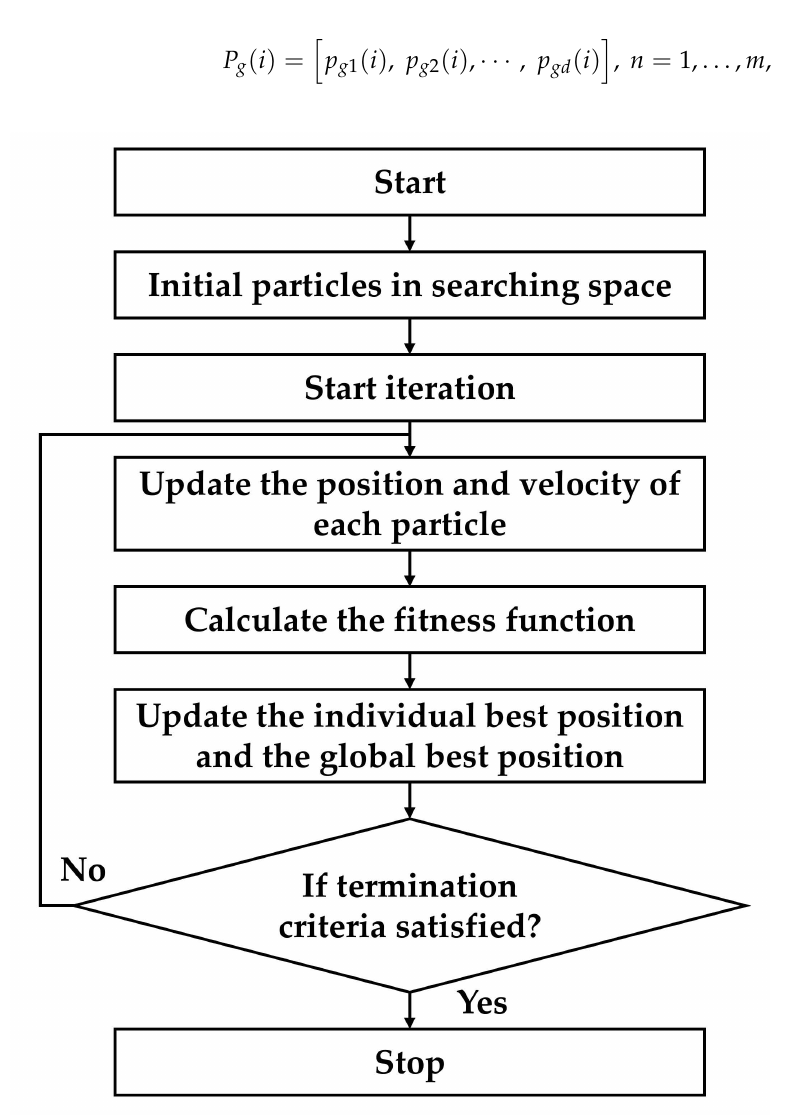
Figure 5. Flowchart of the PSO